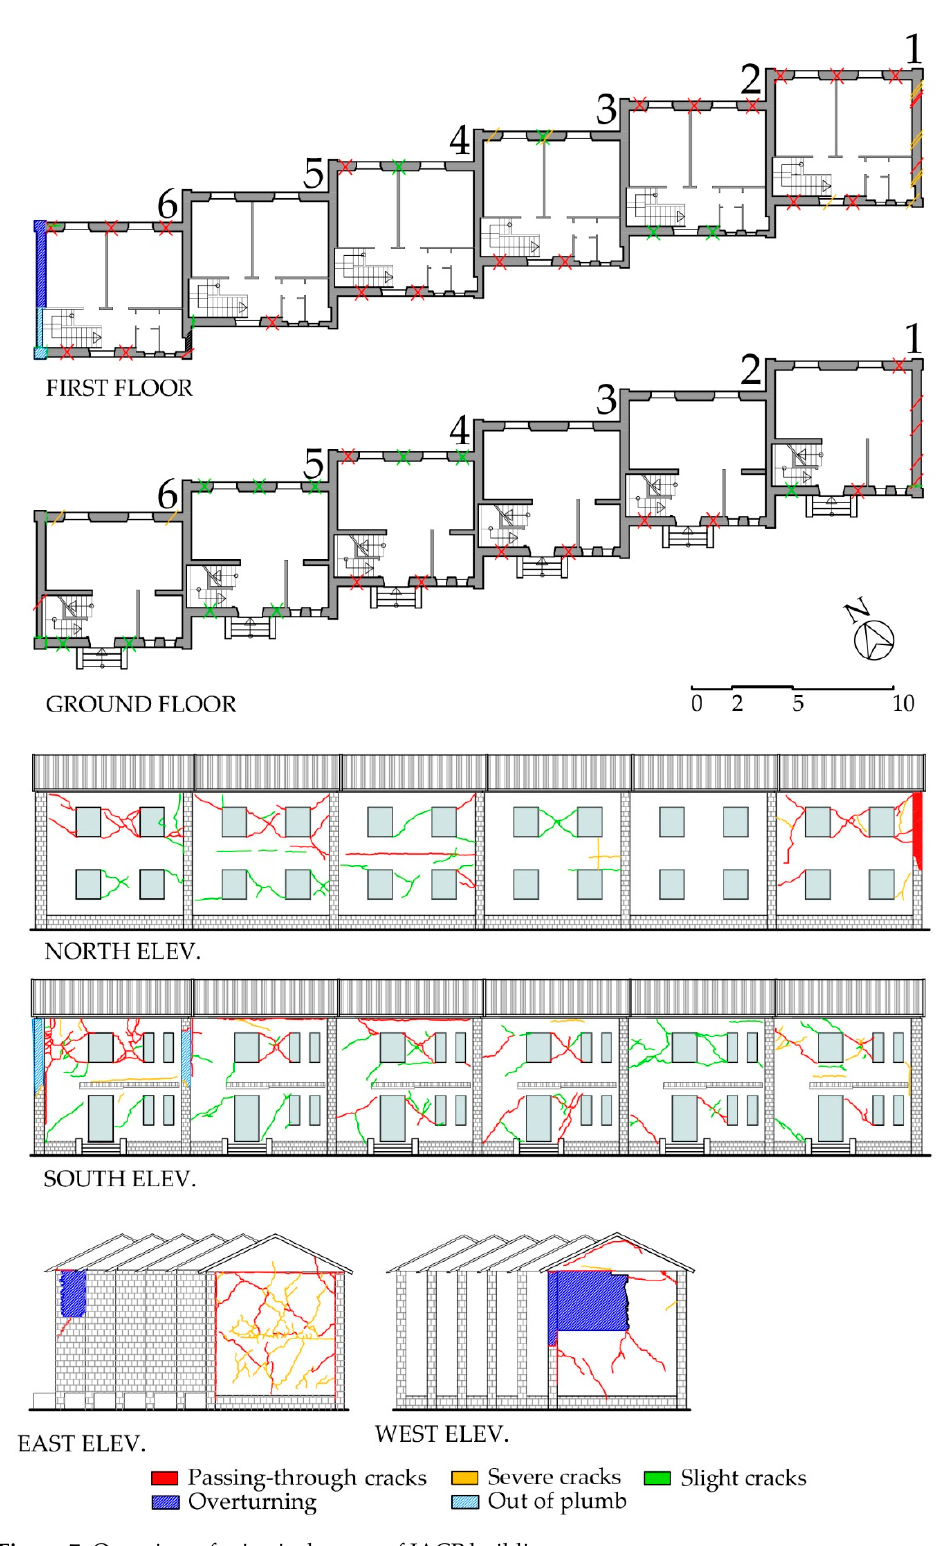
Figure 7. Overview of seismic damage of IACP building.